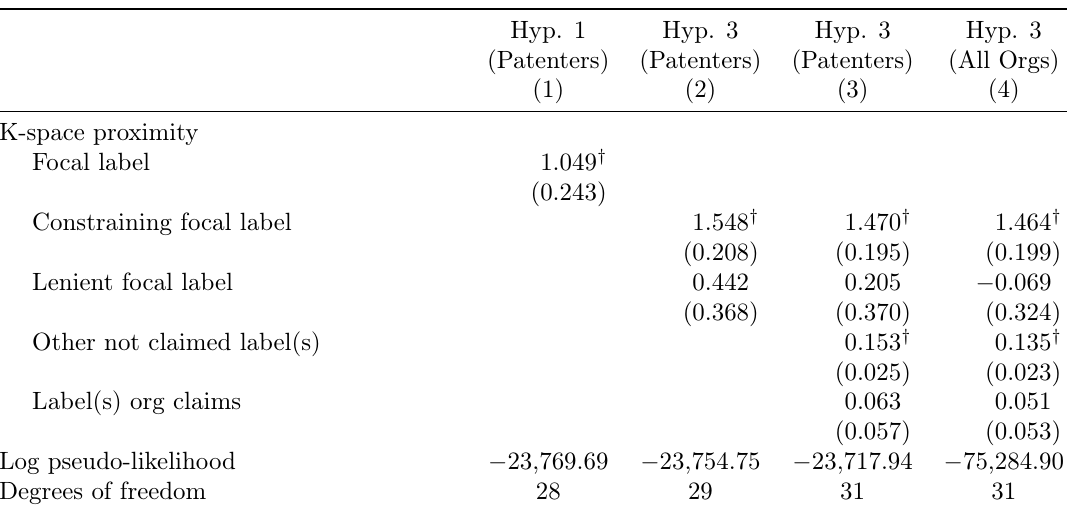
Table 3: Effects of Proximity and Leniency on the Hazards of Adding a Label (ML Estimates of Piecewise-Continuous Hazard